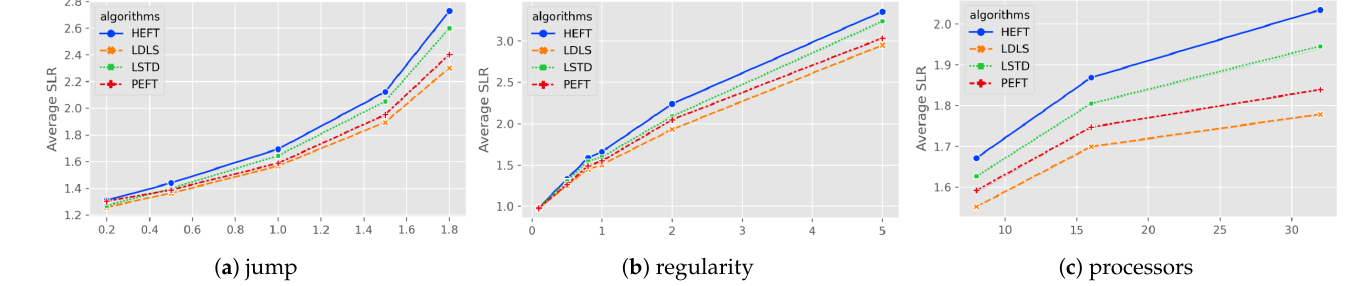
Figure 4. Average SLR for Gauss elimination as a function of ( a ) heterogeneity of processors; ( b ) com- munication to computation ratio; ( c ) number of processors.